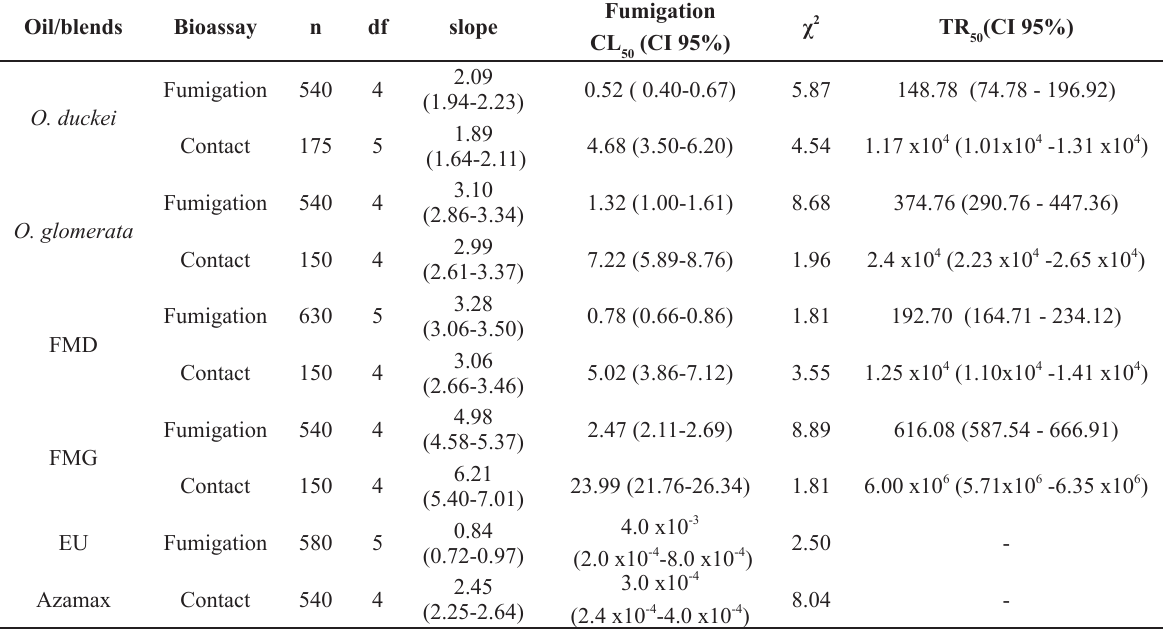
at μL L -1 of air) and residual contact (LC Fumigation toxicity (LC 50 essential oils of O. duckei and O. glomerata